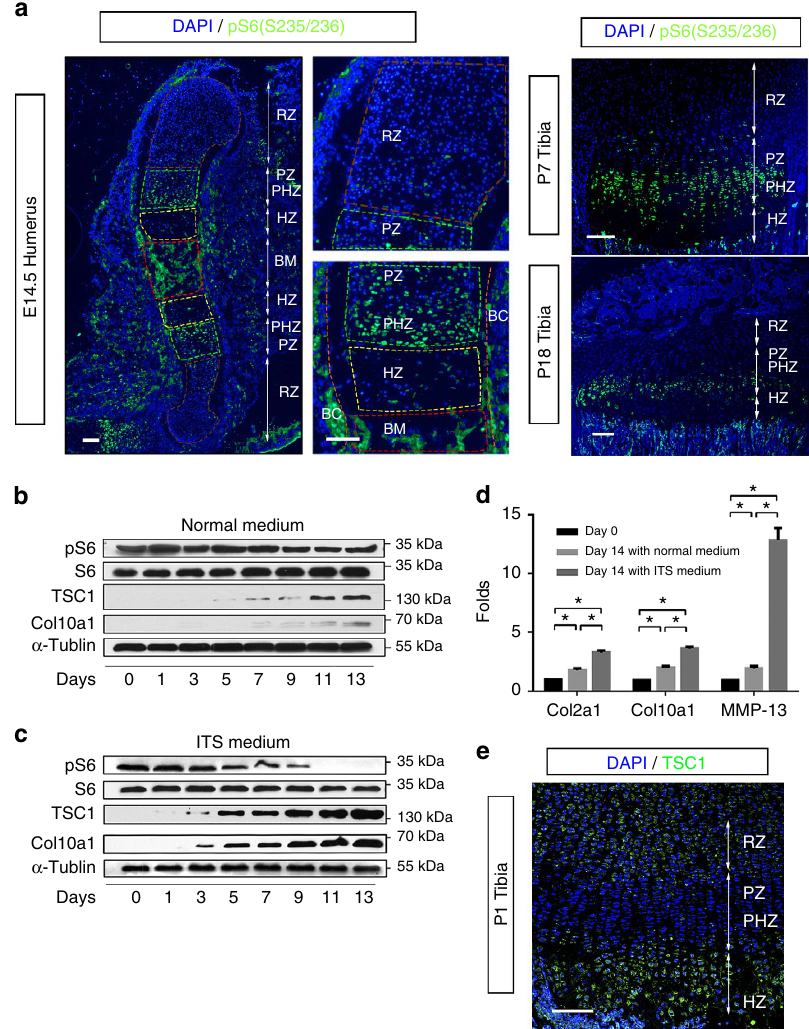
Figure 1 | Dynamic changes of mTORC1 activity during chondrocyte differentiation ( a ) pS6 (S235/236) immunofluorescence in longitudinal frozen sections of mouse humerus at E14.5 or tibias at P7/P18. pS6, green; DNA, blue. Higher magnification is shown on the right. RZ, resting chondrocyte zone; PZ, proliferative chondrocyte zone; HZ, hypertrophic chondrocyte zone; PHZ, prehypertrophic chondrocyte zone; BM, bone marrow cavity; BC, bone collar. Scale bar, 100 m m. ( b ) Western blot of primary cultured chondrocytes isolated from C57BL/6 mice. Lysates were obtained from chondrocytes cultured in growth medium at different time points after confluence. ( c ) Western blot of primary chondrocytes culturedin ITS differentiation medium. Lysates were obtained at different time points after differentiation induction. ( d ) qPCR analysis of chondrocytes cultured in growth or ITS medium on days 0 and 14. ITS, insulin-transferrin-selenium medium; One-way ANOVA (analysis of variance) and Dunnett’s multiple comparison test, * P o 0.05, n ¼ 5; Error bars indicate s.d. ( e ) TSC1 immunofluorescence in longitudinal frozen sections of mouse tibias at P1. TSC1, green; DNA, blue. Scale bar, 100 m